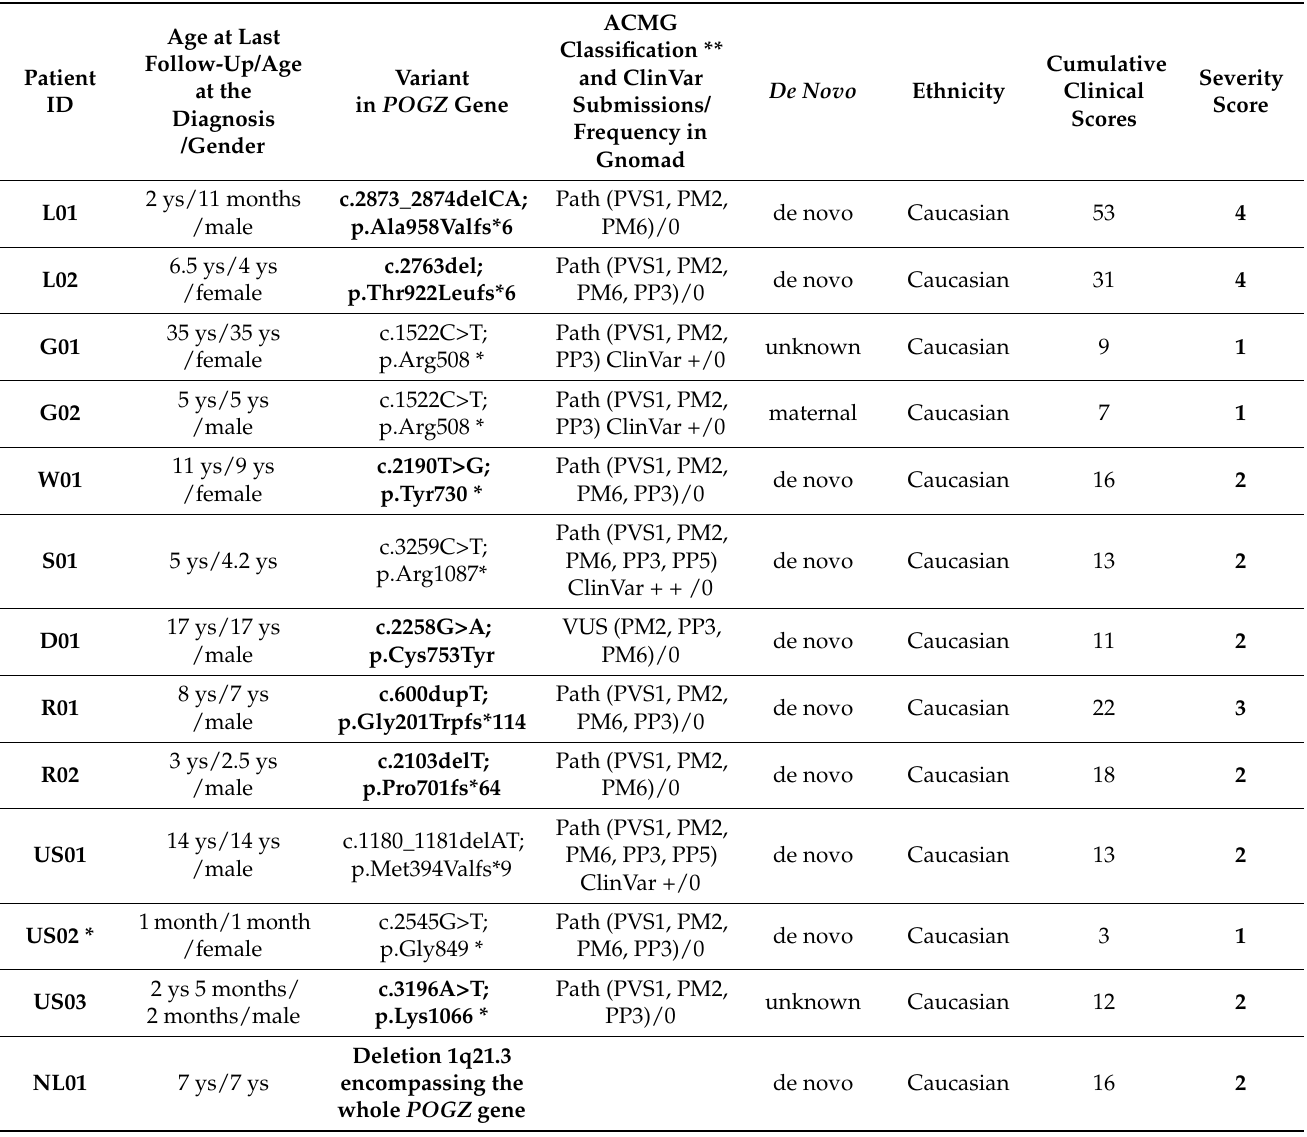
Table 3. Genotypes, cumulative clinical scores and disease severity scores in our POGZ cohort (N =